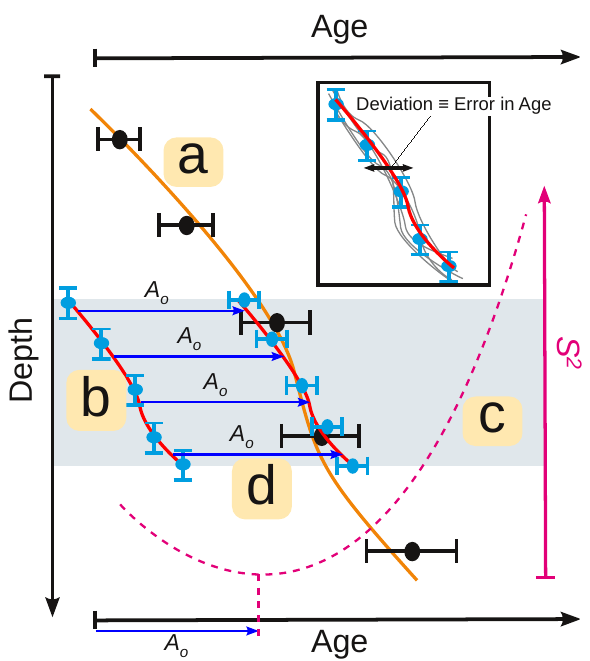
Fig. 3. Incorporating incremental dating: (a) Age Model A (brown curve) of the point estimates (black circles) alone. (b) Age Model B (red curve) of the incrementally dated points (cyan circles) alone. (c) Estimation of minimum least squares separation between the brown and red curves ( S 2 curve in magenta). (d) Shifting of the incrementally dated points by A o to get the final dating table com- bining point estimates and incremental dating. Inset : the standard deviation of all realizations (gray curves) along the age axis is con- sidered the error/uncertainty in the age